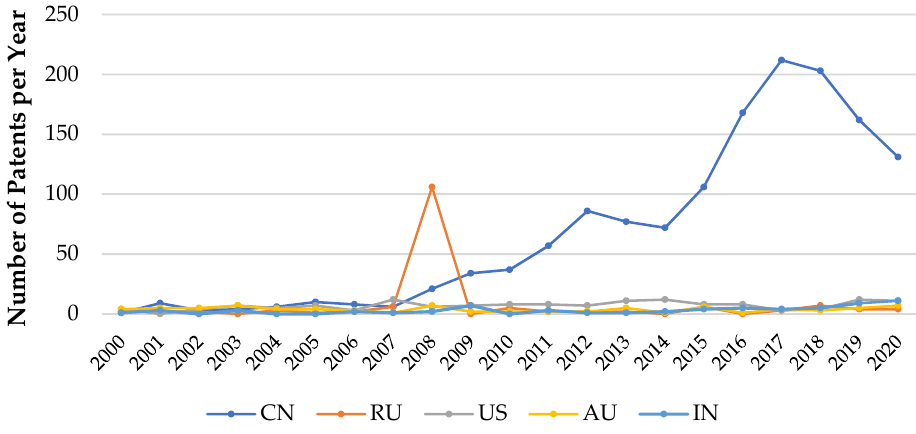
Figure 4. Patent publications for top five countries from Table 4 (CN = China, RU = Russia, US = The United States, AU = Australia, and IN = India).